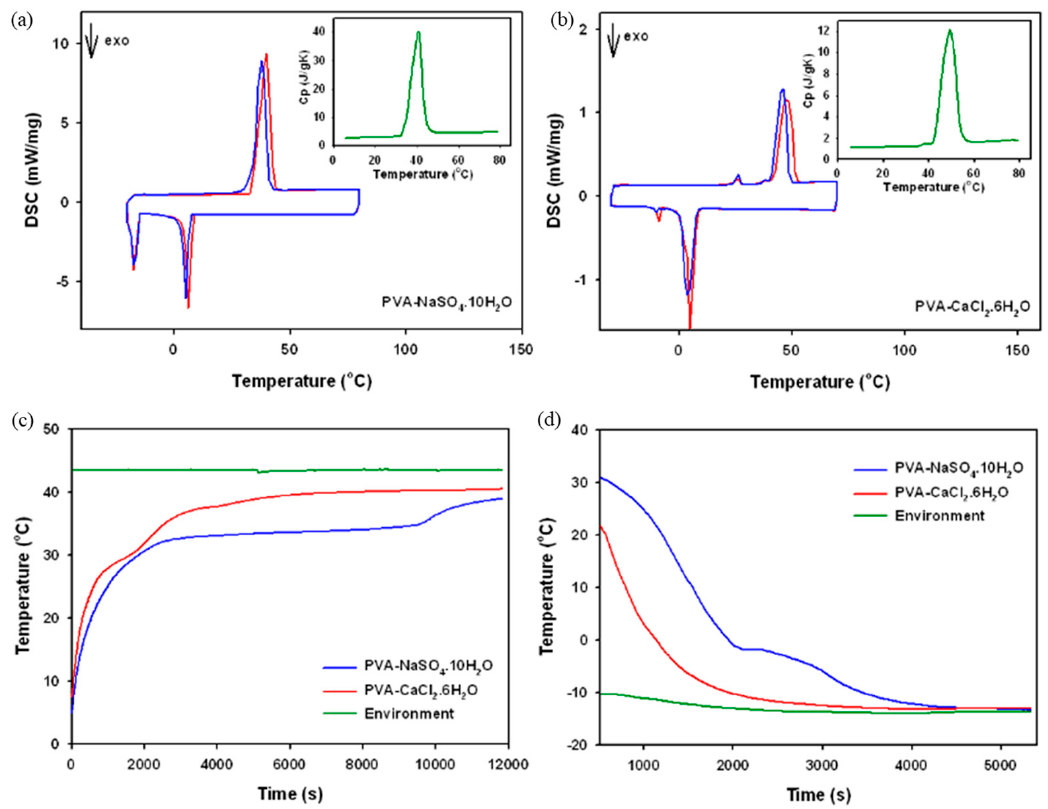
Figure 7. ( a ) DSC of GS + PVA; ( b ) DSC of CCH + PVA; ( c ) freezing and ( d ) melting of GS and CCH with PVA [73].